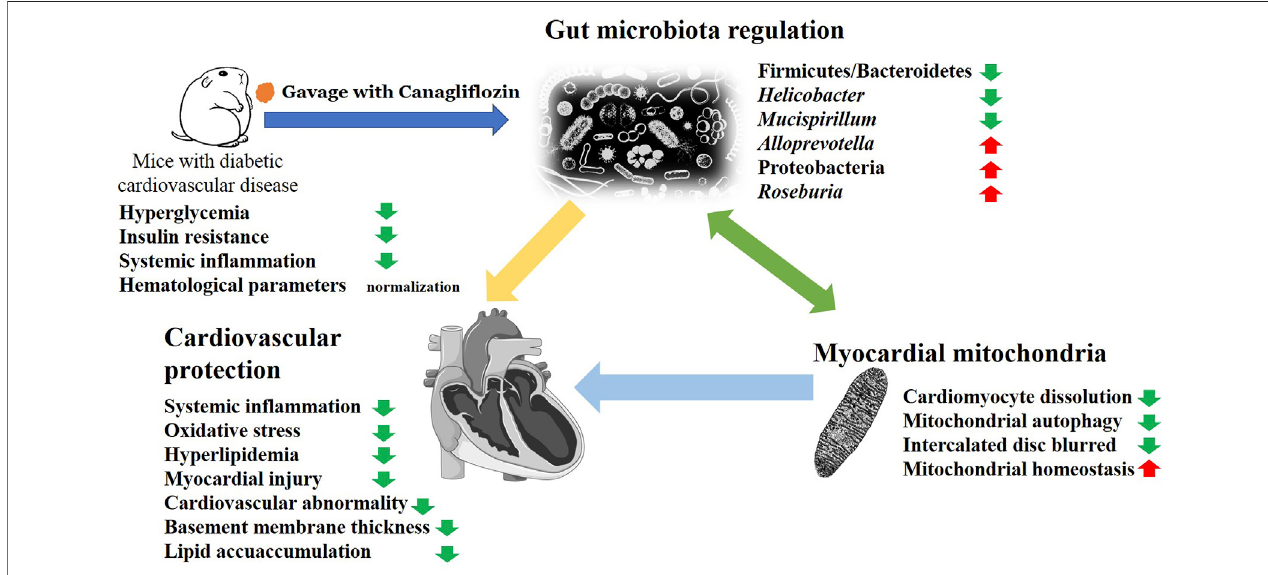
FIGURE 7 | The possible mechanism of Cana on alleviating diabetic cardiovascular disease (CVD). In summary, Cana can effectively alleviate the risk factors for diabetic CVD such as oxidative stress, in fl ammation, hyperlipemia, atherosclerosis, mitochondrial disorder, thickness of vascular basement membrane, and myocardial injury. The amelioration of gut microbiota and myocardial mitochondrial homeostasis represent an important mechanism underlying the cardiovascular bene fi ts.